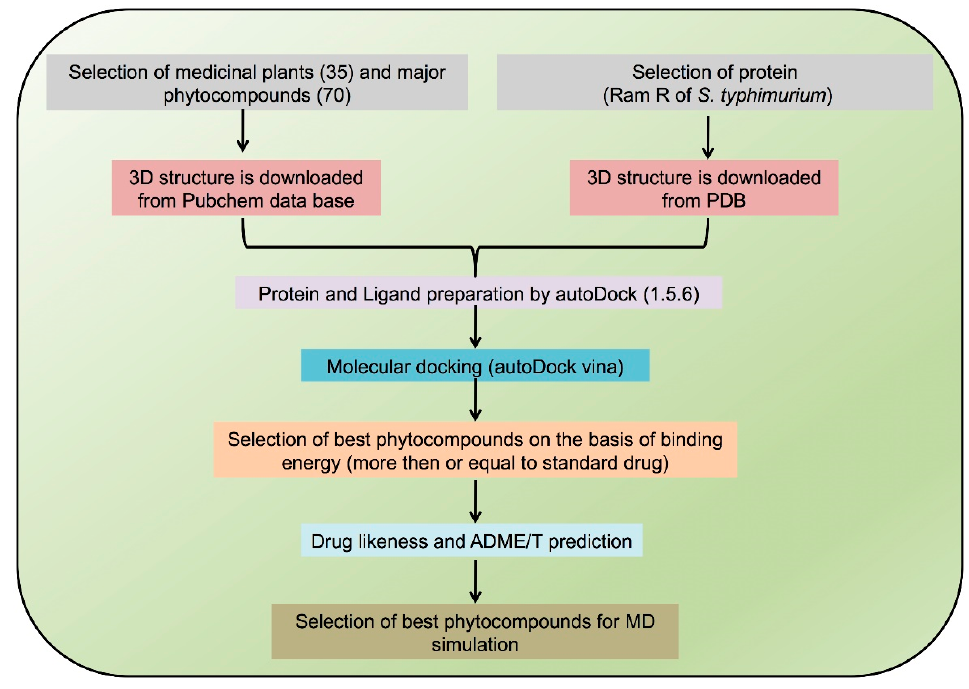
Figure 1. Schematic of experimentation.